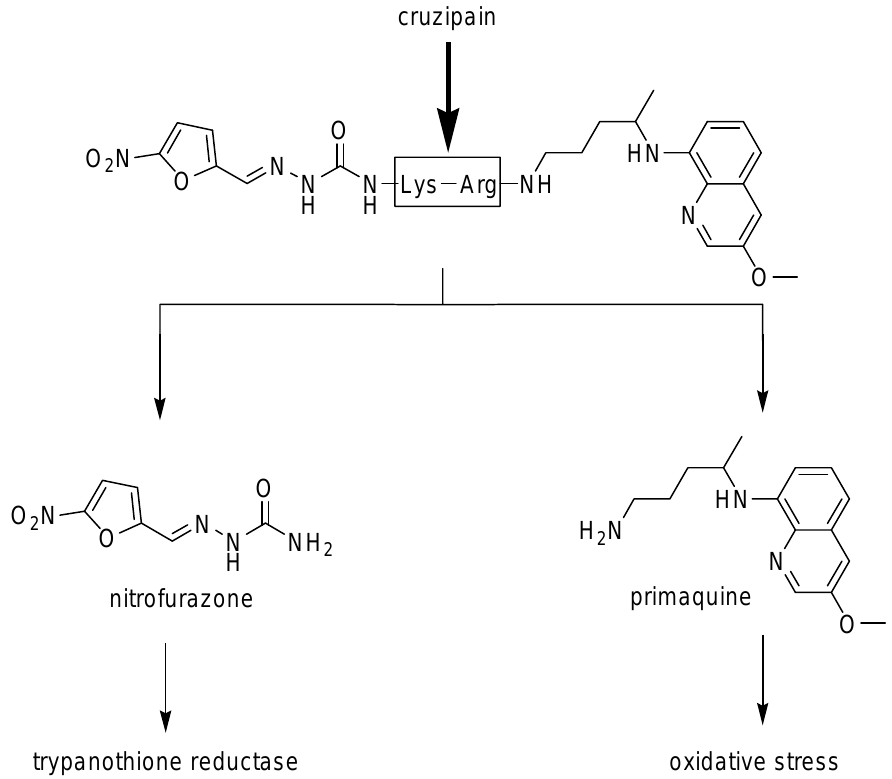
Figure 1. Chemical structure of the mutual prodrug of nitrofurazone and primaquine and its conversion to the parent drugs by